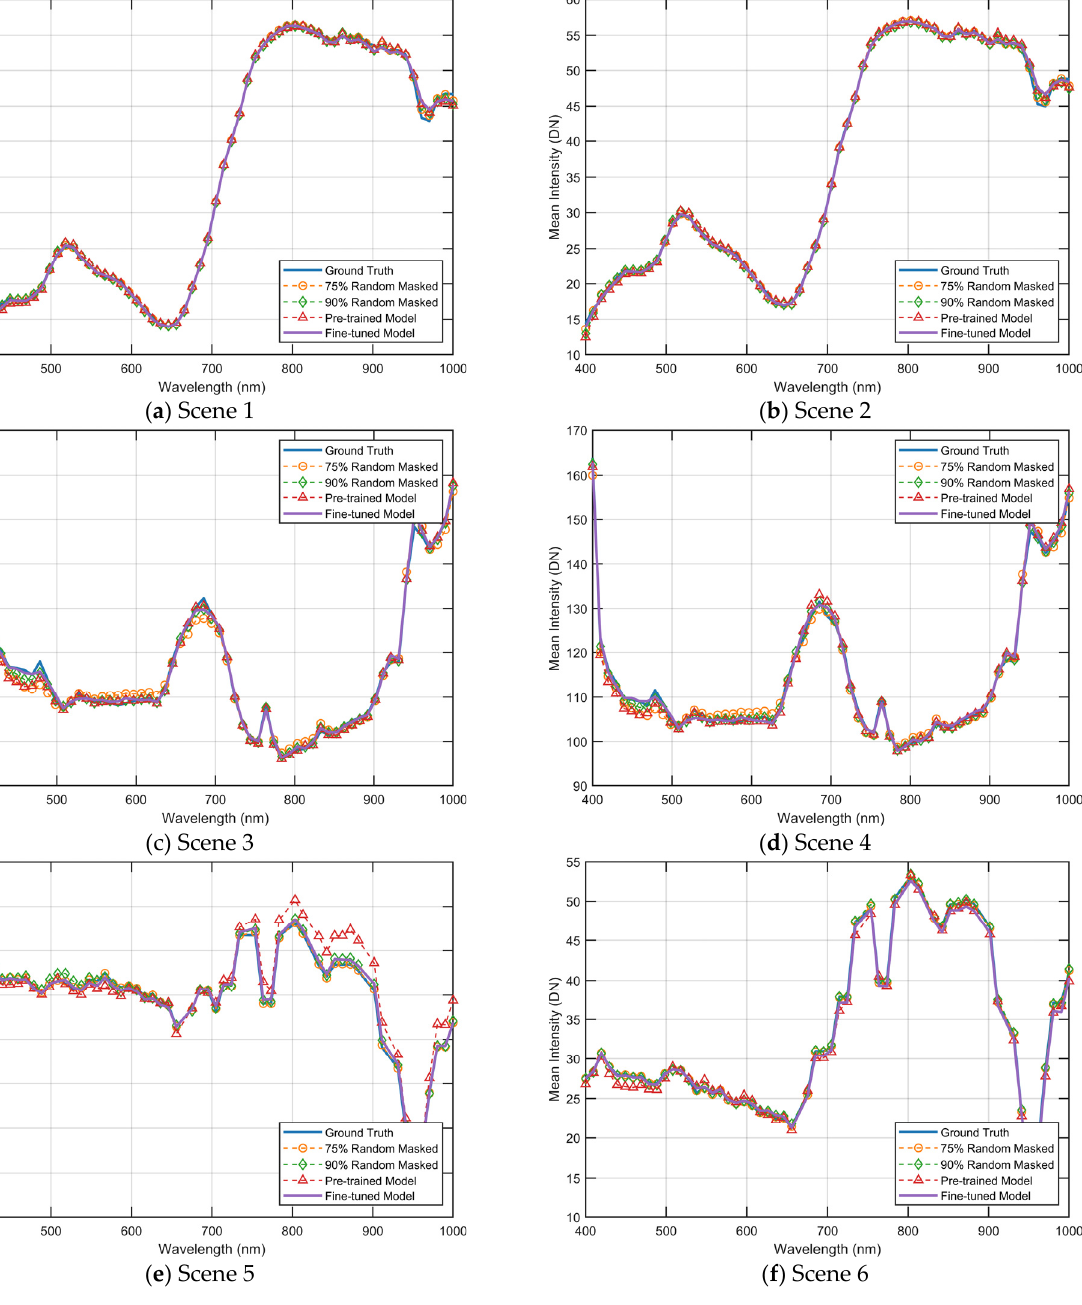
Figure 12. Reconstructed spectral curves comparisons of scenes shown in Figure 10. The spectral curves were averaged in the spatial dimension of the images. DN is a digital number (uncalibrated) between 0 and 255.